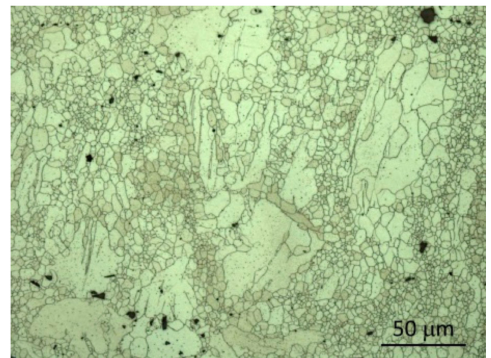
Figure 1. Microstructure taken from the ARB_0 surface.